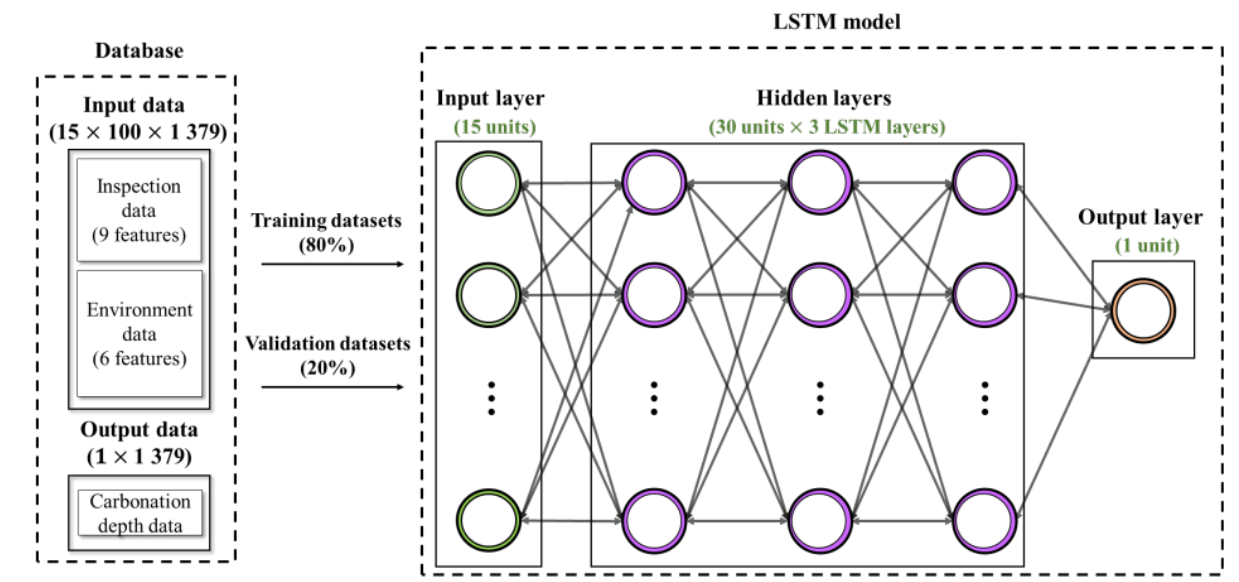
Figure 7. Proposed LSTM model for generating the carbonation models. Table 4. Long short-term memory (LSTM) model layer for the carbonation model.